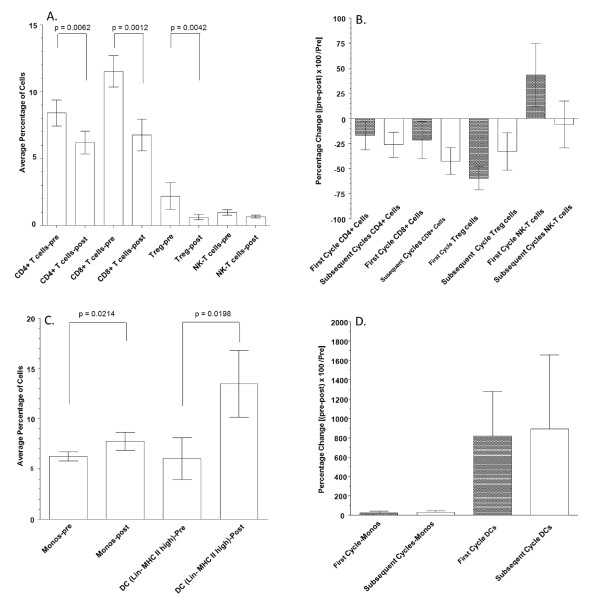
Panel A. Changes in lymphocyte subsets associated with chemotherapy and GM-CSF administration. Individual lymphocyte subsets were evaluated by flow cytometry before and after the administration of chemotherapy and GM-CSF. The subsets that were evaluated include: CD4+, CD8 +, CD4+CD25 high (Treg), CD56+ CD3+ (NK-T) populations. Values depicted represent average percentages of nucleated cells in whole blood samples (n = 23) with error bars depicting standard error values. Significant differences were evaluated with a Wilcoxon matched pairs test. The decrease in CD4 and CD8 T lymphocyte subsets was statistically significant at p = 0.0064 and p = 0.0012 respectively. The decrease in the Treg population was also significant at p = 0. 0042 while the decrease in NK-T cells approached statistical significance p = 0.0997. Panel B. Percent change in lymphocyte subsets across multiple cycles of chemotherapy & GM-CSF. In the first and subsequent cycles of Chemotherapy & GM-CSF the percent change in lymphocyte subsets that include: CD4+, CD8 +, CD4+CD25 high (Treg), CD56+ CD3+ (NK-T) populations, were determined. Percent change was calculated in the standard fashion [(pre- treatment value - post-treatment value)/pre-treatment value] × 100. None of the differences in lymphocyte subset changes between the first and subsequent cycles reached statistical significance by two-tailed unpaired t-test with Welch's correction. Panel C. Changes in monocytes and myeloid DCs associated with chemotherapy and GM-CSF administration. Individual cell populations were evaluated by flow cytometry before and after the administration of chemotherapy and GM-CSF. Monocyte populations were identified as being CD14+. Myeloid dendritic cells (DCs) were identified using a lineage cocktail (CD3, CD20, CD14, CD56) negative cells that had MHC II high expression. Values depicted represent average percentages of nucleated cells in whole blood samples (n = 23) with error bars depicting standard error values. Differences were evaluated with a Wilcoxon matched pairs test. Differences in monocytes and DCs were statistically significant p = 0.0214 and p = 0.0198 respectively. Panel D. Percent change in monocytes and dendritic cells across multiple cycles of chemotherapy and GM-CSF. In the first and subsequent cycles of Chemotherapy & GM-CSF the percent change in monocytes (CD14+ cells) and dendritic cells (DCs) [lineage cocktail (CD3, CD20, CD14, CD56) negative, MHC II high expression] were determined. Percent change was calculated in the standard fashion [(pre-treatment value - post-treatment value)/pre-treatment value] × 100. None of the differences in lymphocyte subset changes between the first and subsequent cycles reached statistical significance by two-tailed unpaired t-test with Welch's correction.